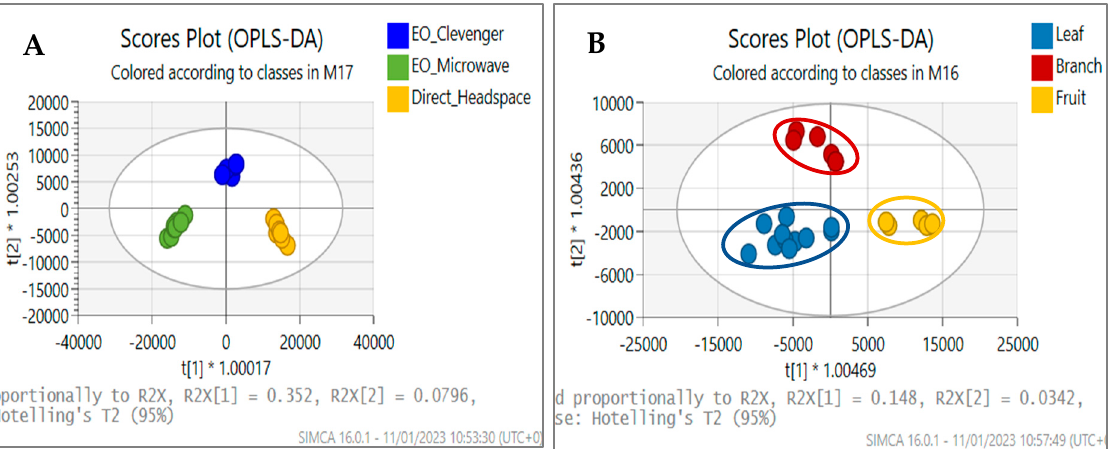
Figure 2. Orthogonal partial least square – discriminant analysis (OPLS – DA) score plots generated from GC-MS data of the essential oils and volatiles from M. gale . ( A ) Distribution of data points based on the treatment, i.e., blue and green denote essential oil (EO) samples obtained by Clevenger and microwave – assisted hydrodistillation, respectively, while yellow denotes volatiles produced by headspace; R 2 x(cum) = 0.878, R 2 y(cum) = 0.967, Q 2 (cum) = 0.896. ( B ) Distribution of data points based on plant parts, i.e., blue, red and yellow denote leaf, branch and fruit, respectively, R 2 x(cum) = 0.937, R 2 y(cum) = 0.639, Q 2 (cum) = 0.377.